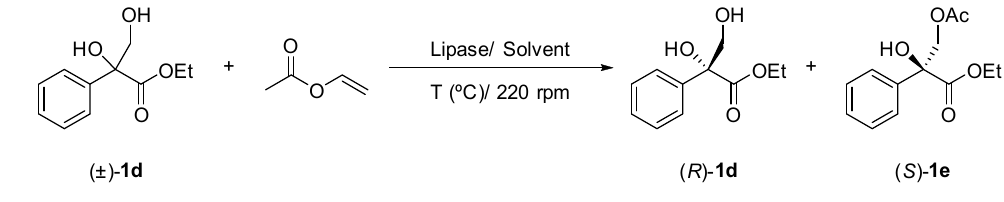
Table 2. Lipase-catalysed acylation of rac -ethyl 2,3-dihydroxy-2-phenylprpanoate ( 1d ) at different reaction conditions.